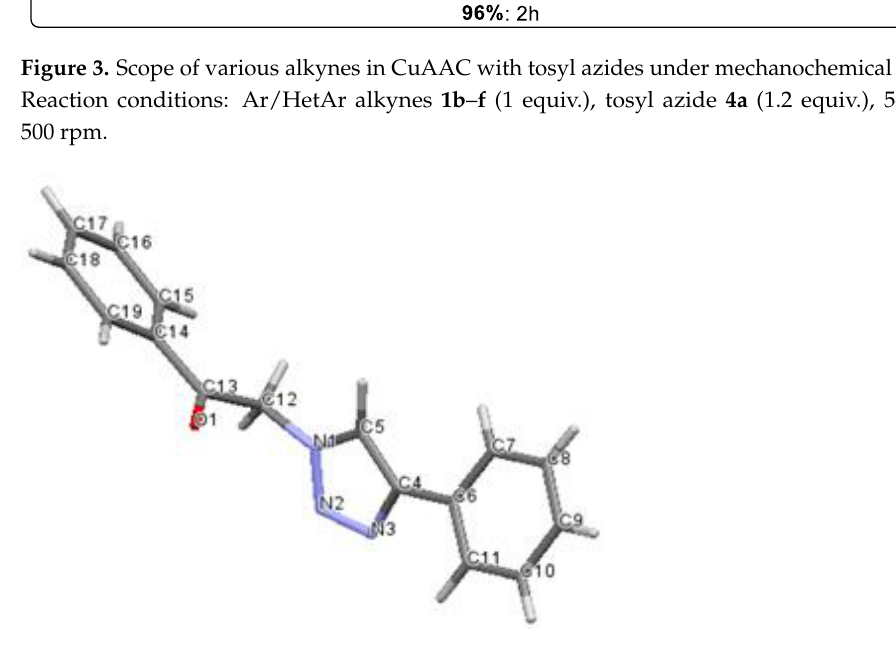
Figure 3. Scope of various alkynes in CuAAC with tosyl azides under mechanochemical conditions.